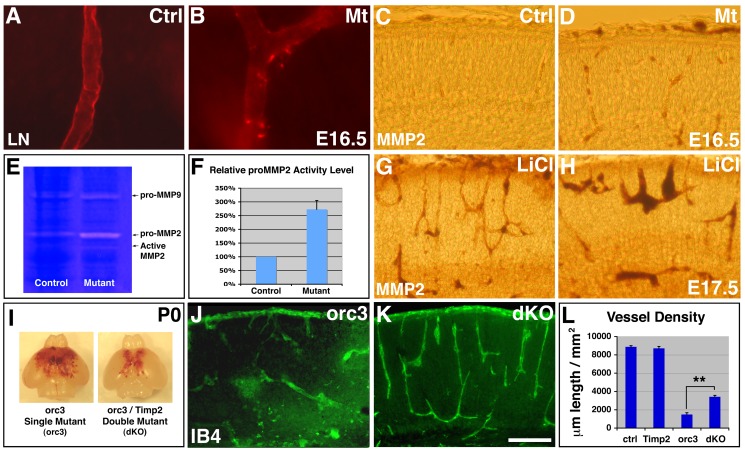
Ectopic Wnt signaling may destabilize cortical vessels in part through up-regulation of MMP-2.(A–B) Effects of radial glial ablation on vessel basement membrane. Staining with highly diluted anti-laminin (LN) antibodies (in red) revealed even labeling along control vessels (A), but frequent bright puncta in mutants (B). (C–D) MMP-2 expression along vessels at E16.5. Antibody staining (in brown) revealed low levels of MMP-2 along control vessels (C), which appear elevated in mutants (D). (E–F) Gelatin zymography. Full-length pro-MMP-2 activity appears substantially up-regulated in mutants at E16.5. Cleaved MMP-2 was also detected in mutants but not in controls. Quantification confirmed an over 170% increase in pro-MMP-2 levels (p = 0.006; n = 3) (F). (G–H) MMP-2 expression in brains treated with LiCl at E17.5. LiCl dramatically elevated MMP-2 expression along cortical vessels. (I–L) Effects of Timp2 mutation on vessel regression in orc3 mutants. Introduction of Timp2 mutation into orc3 mutant background substantially suppressed brain hemorrhage (I) and restored cortical vessel network (K and J). Analysis by ANOVA followed by Tukey's post hoc test shows that Timp2 mutation alone has no significant effects on vessel density, but suppresses vessel regression in orc3 mutants (** p<0.01, n = 6) (L). Scale bar (in K): 70 µm for (A–B) and 200 µm for (C–D, G–H, and J–K).